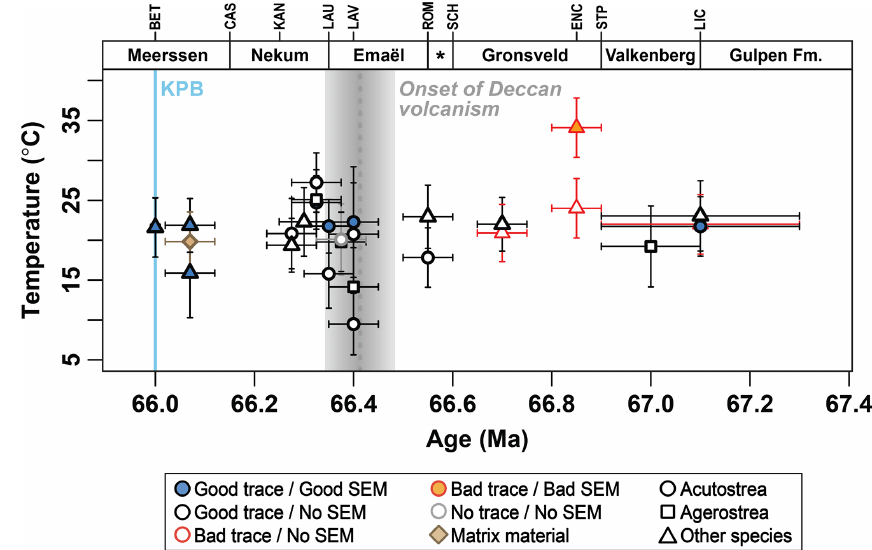
Figure 5. Maastrichtian (cid:49) 47 -derived paleotemperatures for all samples. Samples shown in red ( n = 4) did not pass screening thresholds and were not included in further interpretation. Error bars represent the larger of either the internal or long-term 1SE (see text). Onset of the main Deccan Traps eruptions (grey shading) at 66 . 413 ± 0 . 067Ma (Sprain et al., 2019). Member names and horizon abbreviations are labeled across the top of the figure (see Fig. 2). ∗ Schiepersberg